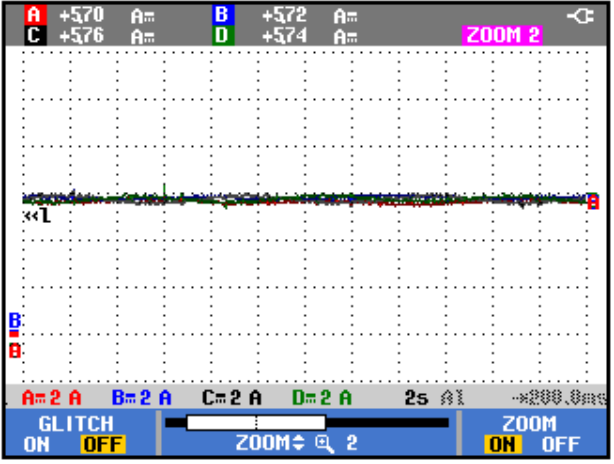
Figure 26. Output currents during simultaneous current attacks.